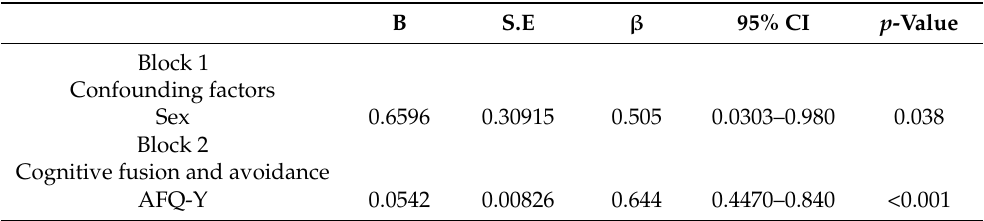
Table 2. Multiple hierarchical linear regression model examining the independent effect of demo- graphic features and cognitive fusion (AFQ-Y) on emotional eating (DEBQ-EE). B S.E β 95% CI p -Value Block 1 Confounding factors Sex 0.6596 0.30915 0.505 0.0303–0.980 0.038 Block 2 Cognitive fusion and avoidance AFQ-Y 0.0542 0.00826 0.644 0.4470–0.840